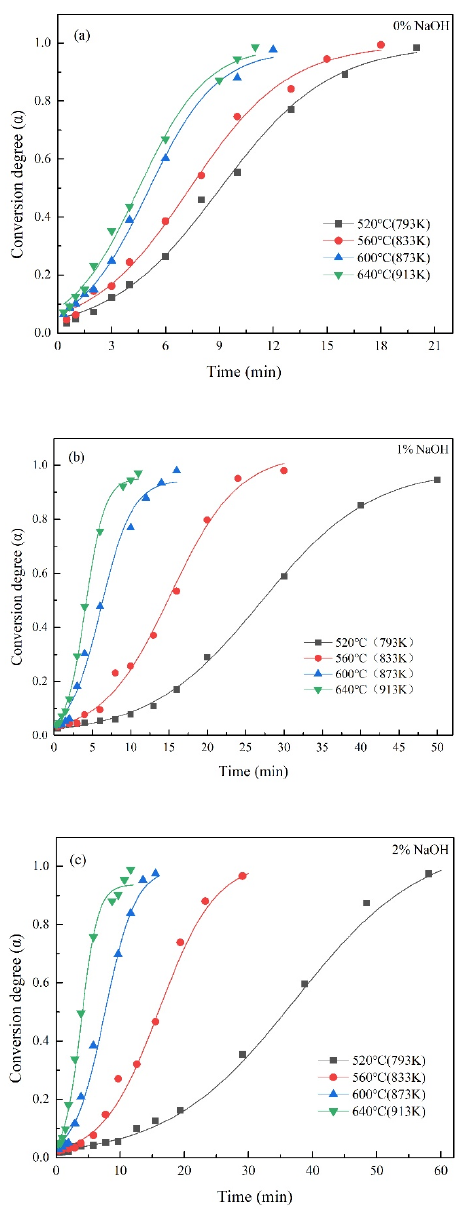
Figure 3. Conversion degrees of hematite under different conditions (( a ) 0% NaOH, ( b ) 1% NaOH, ( c ) 2% NaOH).